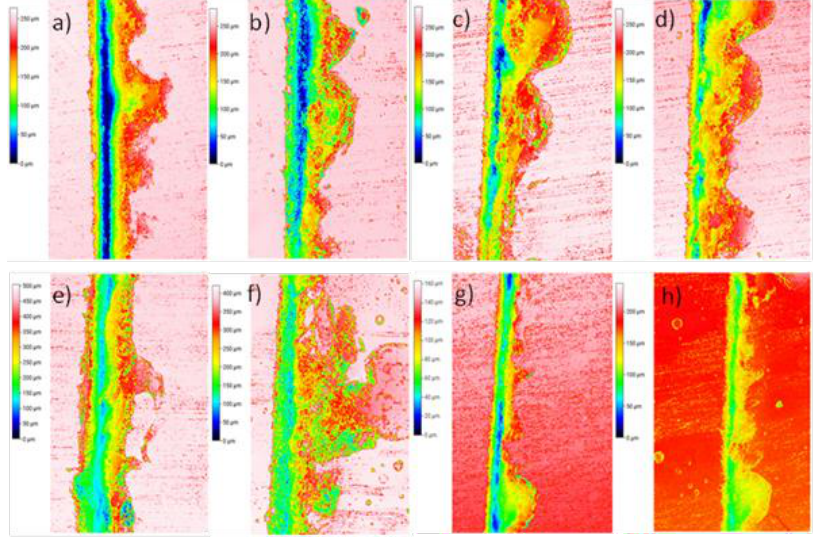
Figure 7. Images of optical profilometry for PCL/epoxy blends with 15% wt PCL before (left image of each pair) and after (right image of each pair) the self-healing process at: ( a , b ) 90 ◦ C, ( c , d ) 110 ◦ C, ( e , f ) 130 ◦ C, ( g , h ) 150 ◦